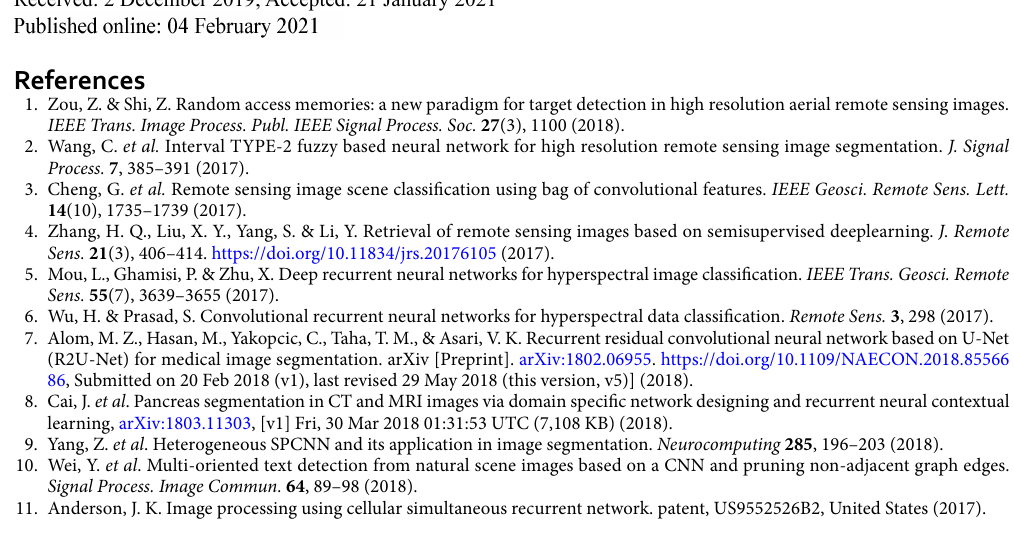
Table 8. Effect of different deep learning models on the evaluation criteria values for Quick Bird images.